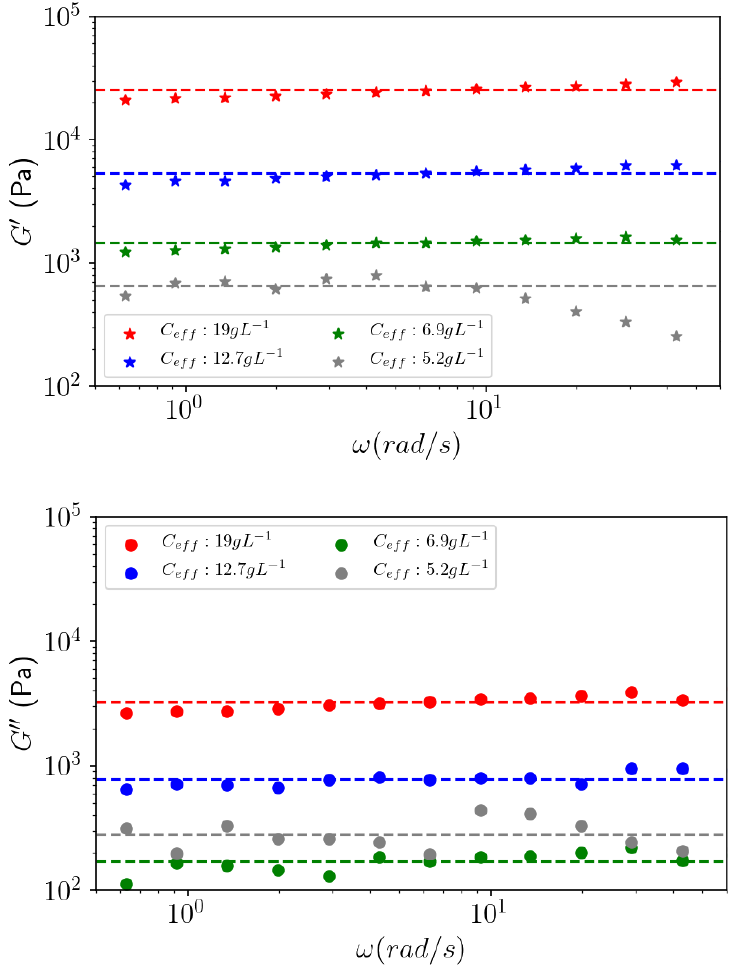
Figure 11. Influence of the effective APP-E pectin effective concentration on the viscoelastic behavior ( G′ and G″) of gels as a function of the frequency for an applied oscillatory strain γ = 0.1%. From these data, it can be observed that stronger gels are formed as the concentration of APP-E increases (Figure 11). At 10, 6.7, and 3.3 g L −1 of the prepared concentration, G′ was approximately 10 times higher than G″ . In the observed frequency range, those